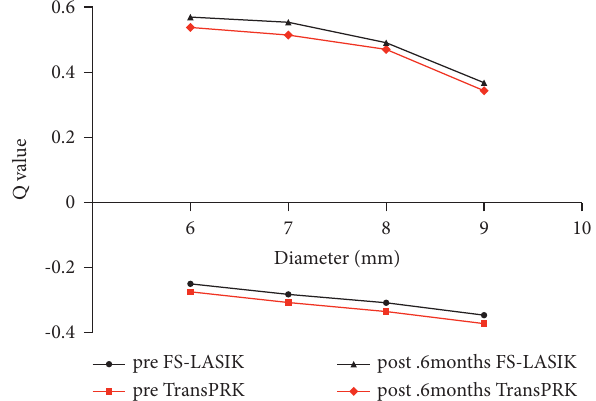
Figure 1: Comparison of the Q value changes in the FS-LASIK and Trans-PRK groups. The Q value of the anterior corneal surface significantly shifted to a positive value after the FS-LASIK and Trans-PRK groups. No significant difference between FS-LASIK and Trans-PRK in the changes of the Q value of the anterior corneal surface was found.